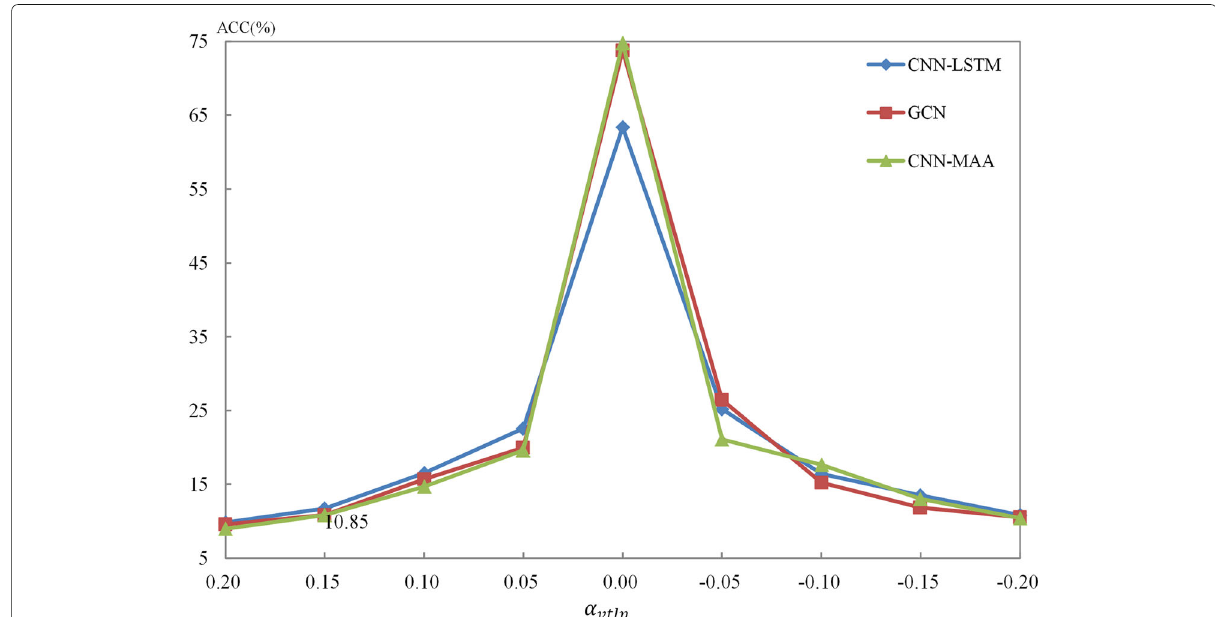
Fig. 6 Description of the three models under the Vocal Tract Length Normalization attack